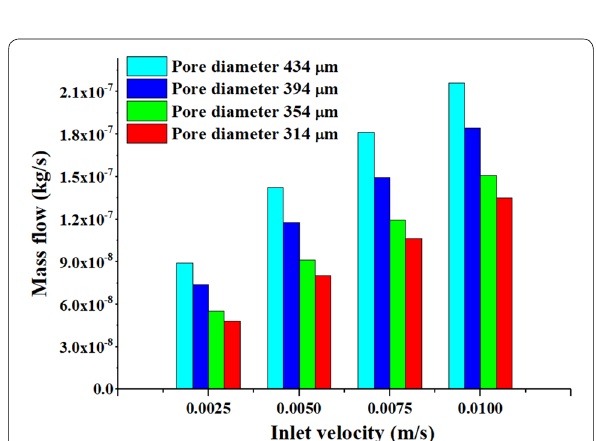
Figure 15 Mass flow in the bottom outlets obtained using CFD simulation